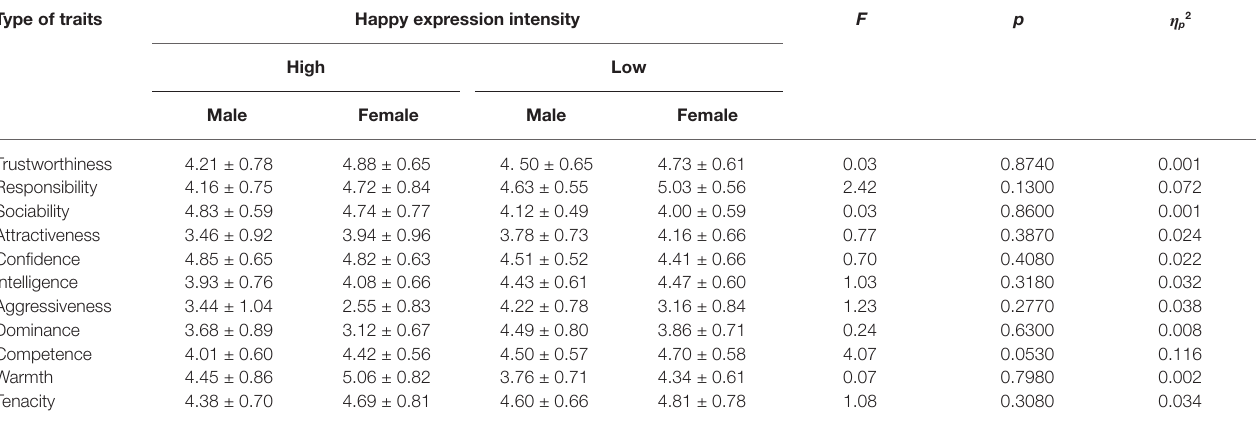
TABLE 6 | Evaluation scores for the different social traits under happy expression intensity and facial gender (M ± SD). Type of